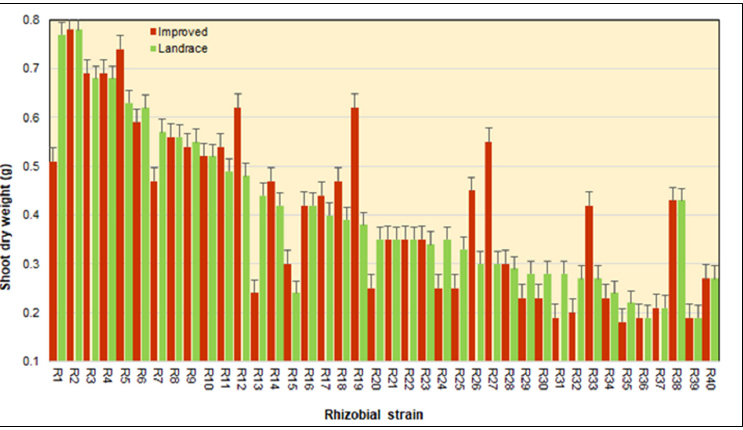
Figure 3. The effects of inoculation with rhizobial strains on the nodule dry weight per plant of the landrace and improved pigeonpea genotypes. The identity of each rhizobial strain (R1–R40) is described in Table 2 and the results of the statistical analysis are reported in Tables S1 and S2 (depending on the genotype).